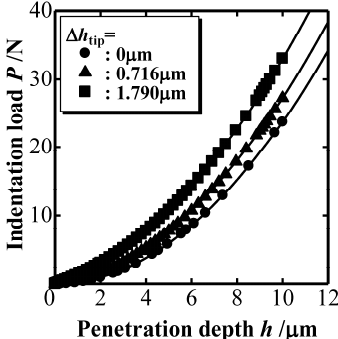
Figure A2. Indentation load P vs. penetration depth h curves obtained with truncated conical indenters.